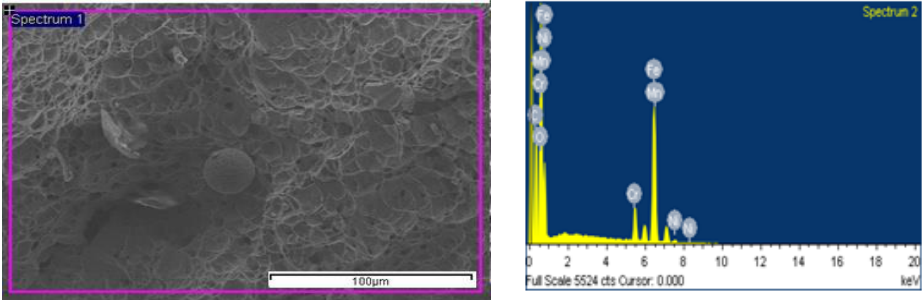
Table 11. Elements present in fracture face of TIG weld zone. Figure 17. EDS / SEM spectrum analysis of fracture face of TIG weld zone. Figure 17. EDS/SEM spectrum analysis of fracture face of TIG weld zone.